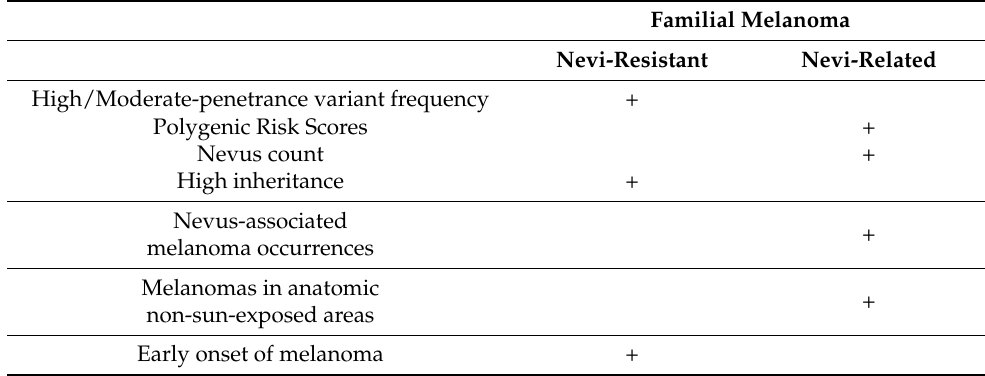
Table 2. Features mostly represented in nevi-resistant and nevi-related familial